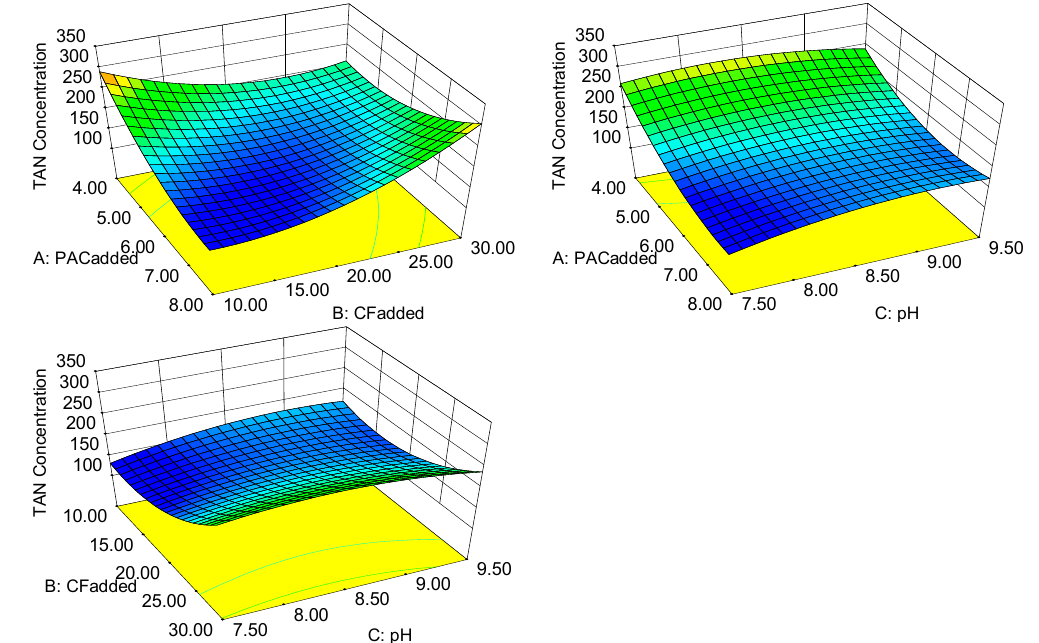
Figure 4. Response surface of the TAN concentration.